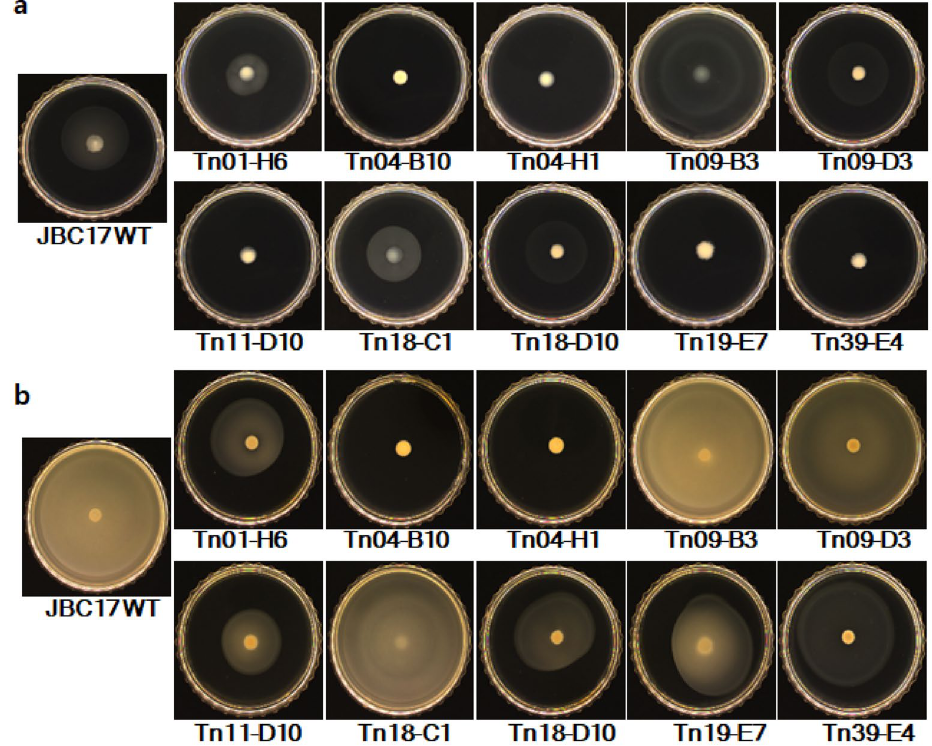
Figure 8. Effect of mutations on swimming motility of Pseudomonas putida JBC17 and its mutants. Each strain was grown overnight in LB broth and inoculated in the center of nutrient-poor 10% PDA ( a ) and -rich 100% PDA ( b ) containing 0.3% agar and incubated for 48 h and 24 h,